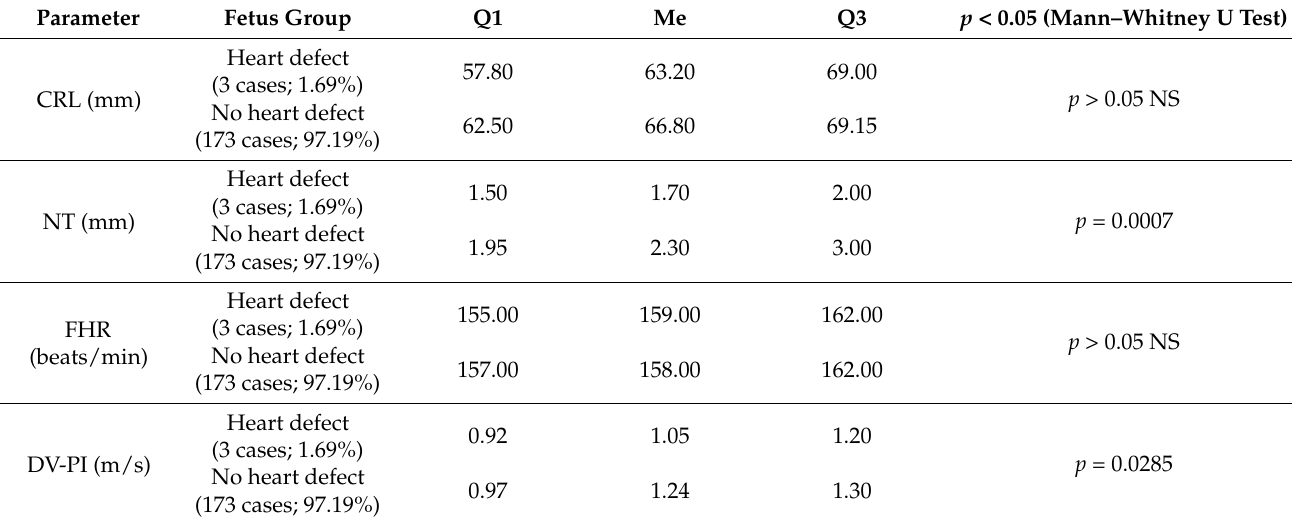
Table 2. Assessment of the parameters describing the growth and health of the fetus with or without a congenital heart defect based on ultrasound examination in a group of women who became pregnant as a result of sexual intercourse after the induction of ovulation.